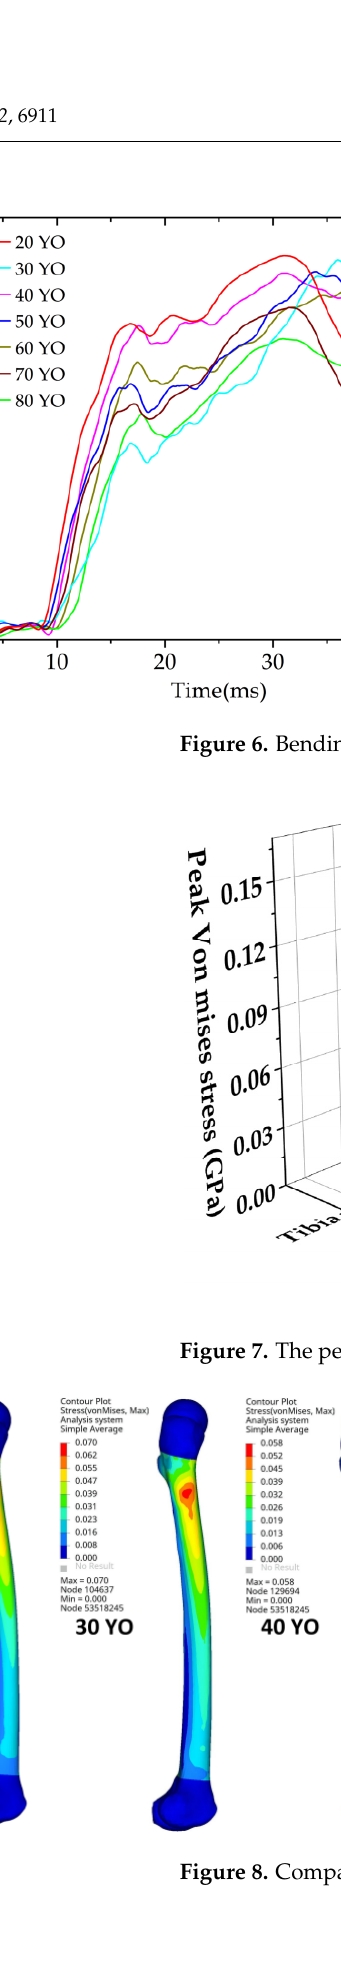
Figure 9. Comparison of the Von mises stress contours of the tibia in seven ages at 40 km/h. 4. Discussion In forensic practice, the injury mechanisms and degrees of lower limb injuries in various traffic accidents are complex and diverse. The injury characteristics of the lower limbs urgently need to be clearly understood in multiple directions in forensic identifica- tion. The age of pedestrians is also an essential factor. With an increase in age, the bone structure of the human body will change to different degrees, and the damage in traffic accidents will also show different characteristics due to different ages. A more critical is- sue is that age-related lower limb injuries are nonlinear [50–52]. In the past, studies re- lated to finite element analysis have considered the size and height of pedestrians. In fo- rensic science, the identification of lower limb injuries is based chiefly on empirical judgment. We reviewed the previous studies on the material properties of long bones by scholars. However, we found that the previous studies were still from a macroscopic perspective because the material properties of the long bones of the lower limbs varies with different races and ages. This study conducted a stratified sampling study on the material properties of human lower limb long bones in China, explored the correlation between the material properties of the femur and tibia with age, and made specific com- parisons with previous studies. The Young’s modulus and BMD of the spongy bone at each site. The density values are relatively small. We could not perform statistical and linear fitting on the Young’s modulus and BMD of the spongy bone at each site because we found that the spongy bone was relatively evenly distributed inside the long bone. The difference is relatively insignificant, so we did not analyze and compare such situations. We used a more de-